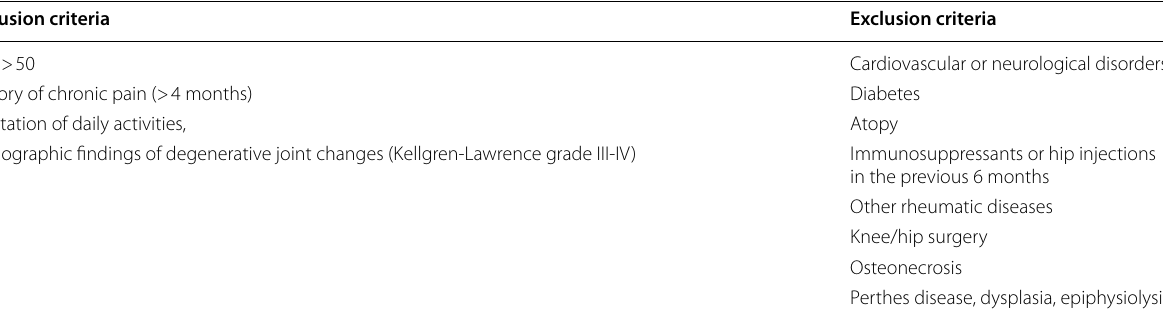
Table 1 Inclusion and exclusion criteria of patients with knee and hip osteoarthritis Inclusion criteria Age >